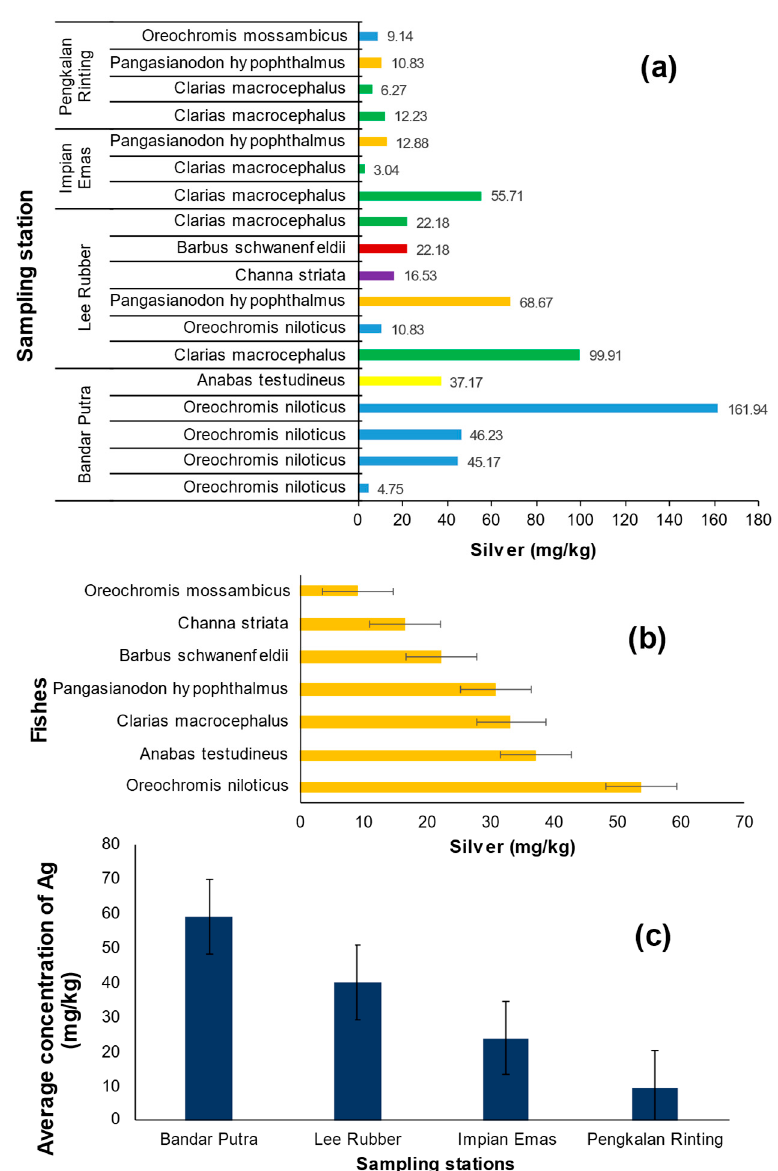
Figure 7. ( a ) Ag concentrations throughout the fi sh species and sampling stations, ( b ) overall concentrations by fi sh species, and ( c ) average Ag concentrations by sampling station.